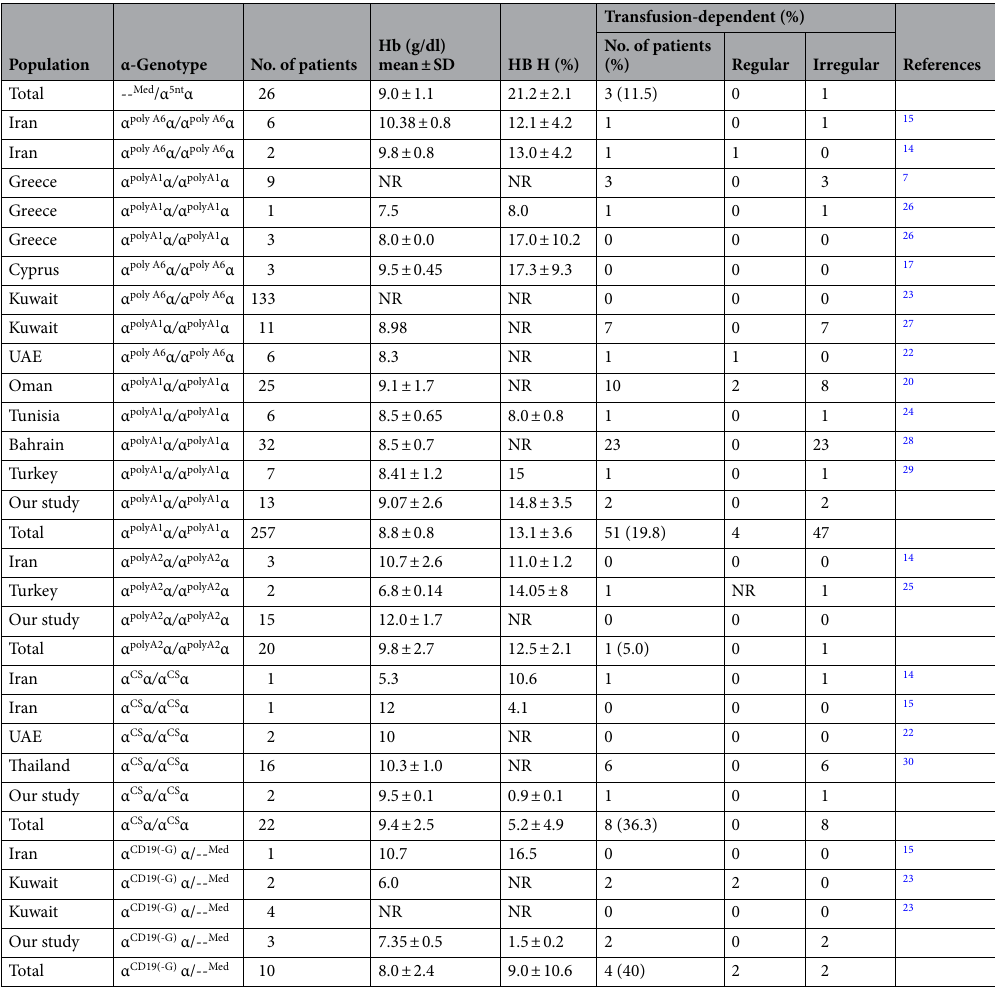
Table 2. Previous studies reported similar genotypes of our studies from patients with Hb H disease. NR Not